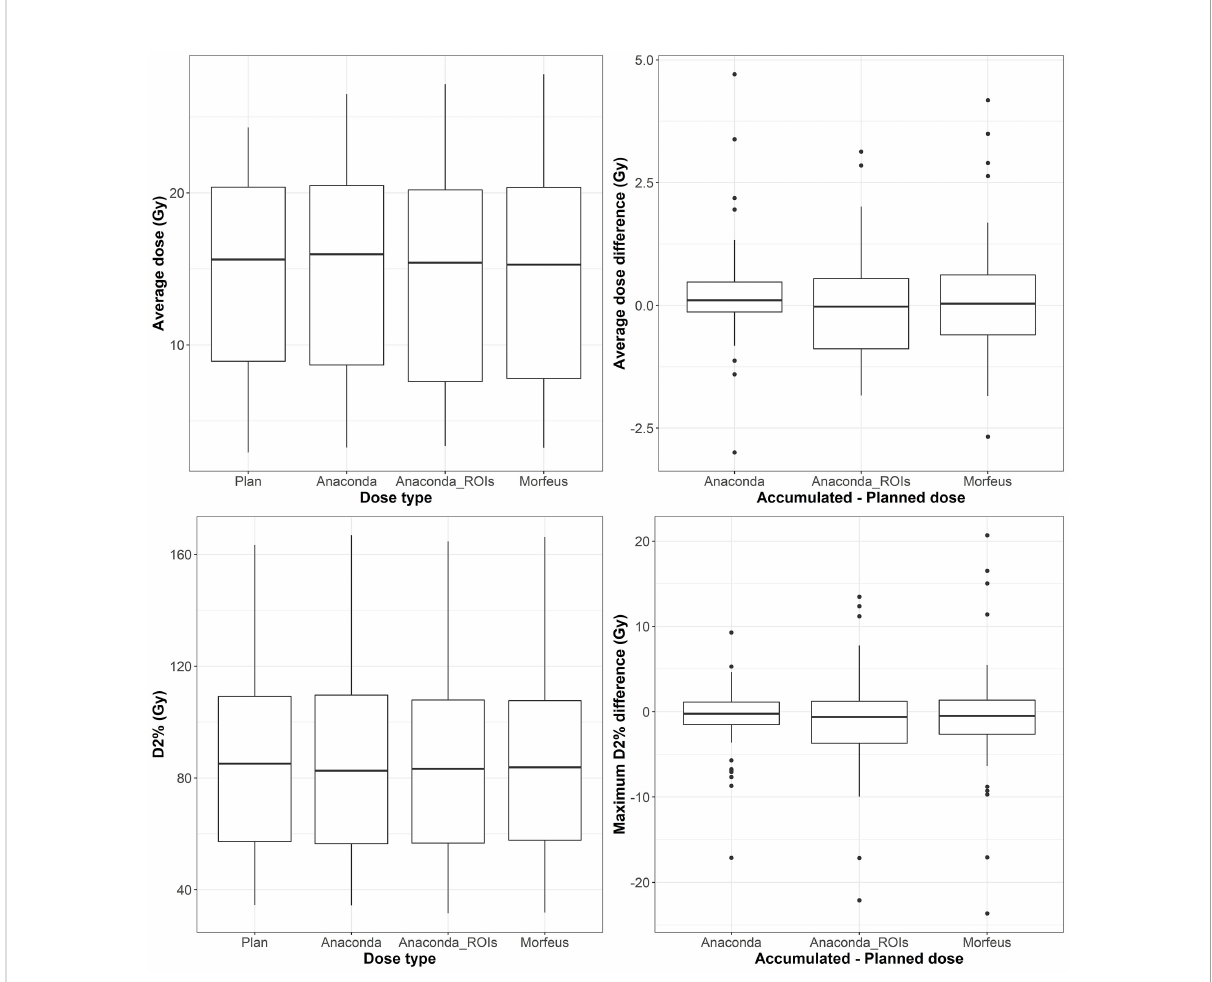
FIGURE 2 Left: average (top row) and maximum (bottow row) planned and accumulated normal liver EQD2 (Gy). Right: difference between accumulated and planned